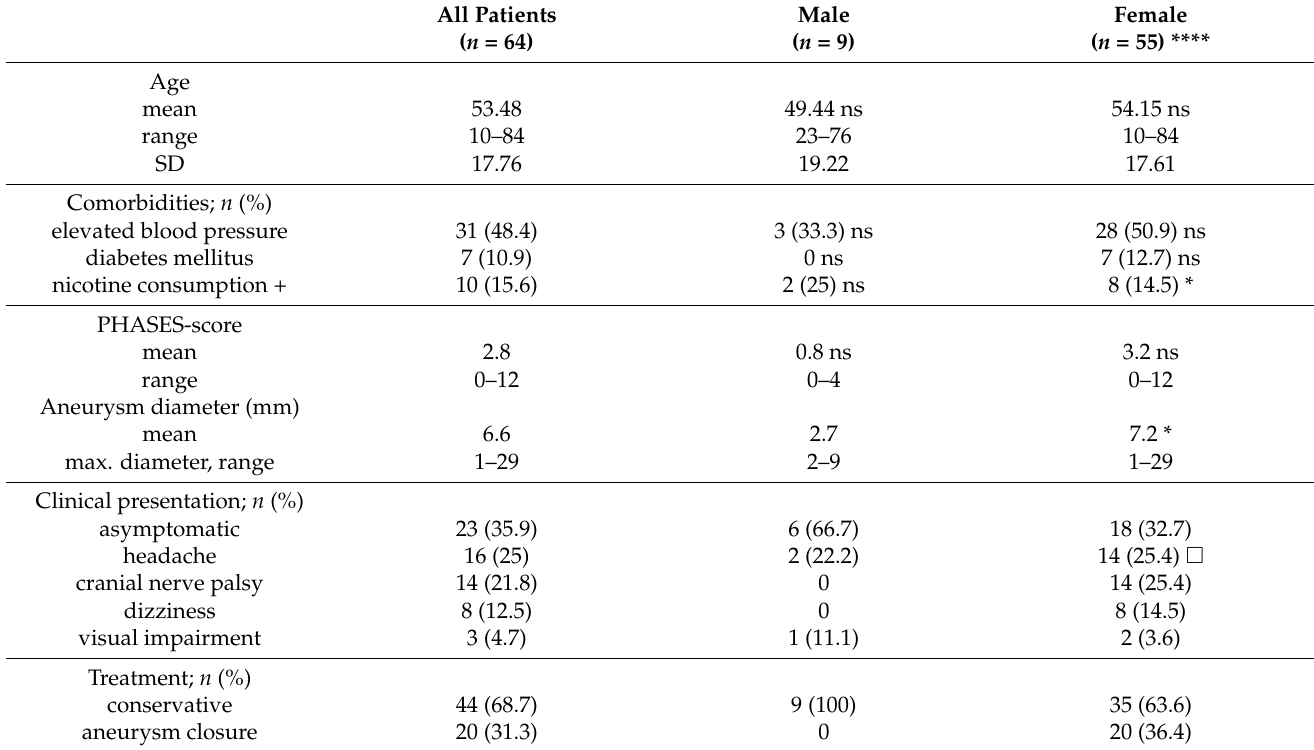
Table 1. Patient